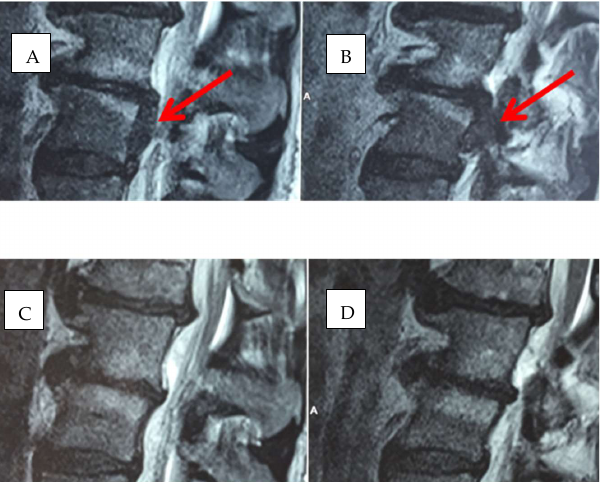
Figure 5. ( A – D ): Herniated disc in L4-L5 before (arrows) and after treatment with oxygen-ozone + ALA + PEA + Myrrh.